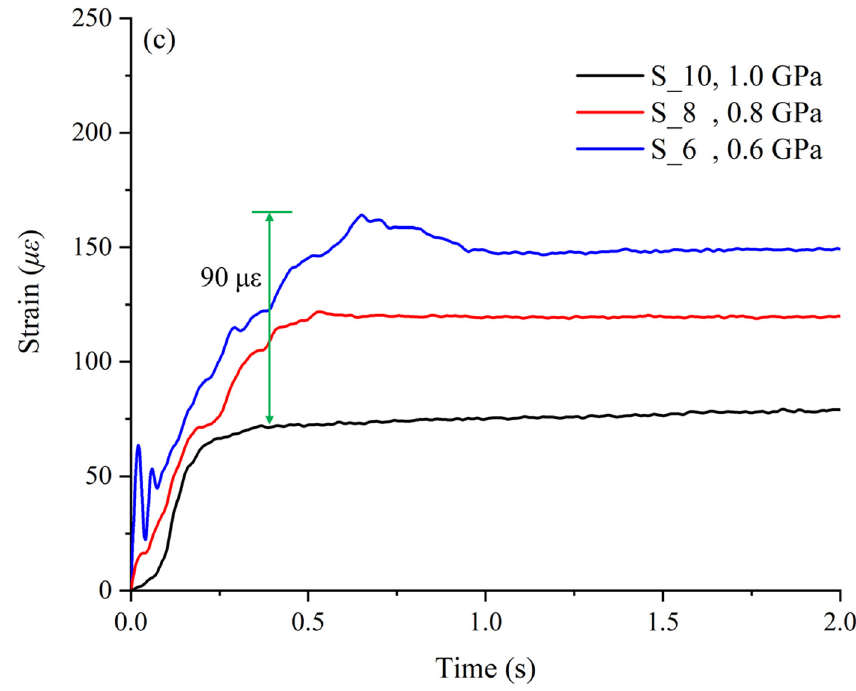
Figure 5. ( a ) Impact force time history curve with different barrier stiffness; ( b ) strain of barrier when peak impact force occurred; and ( c ) total strain time history curve of different stiffness of barrier.